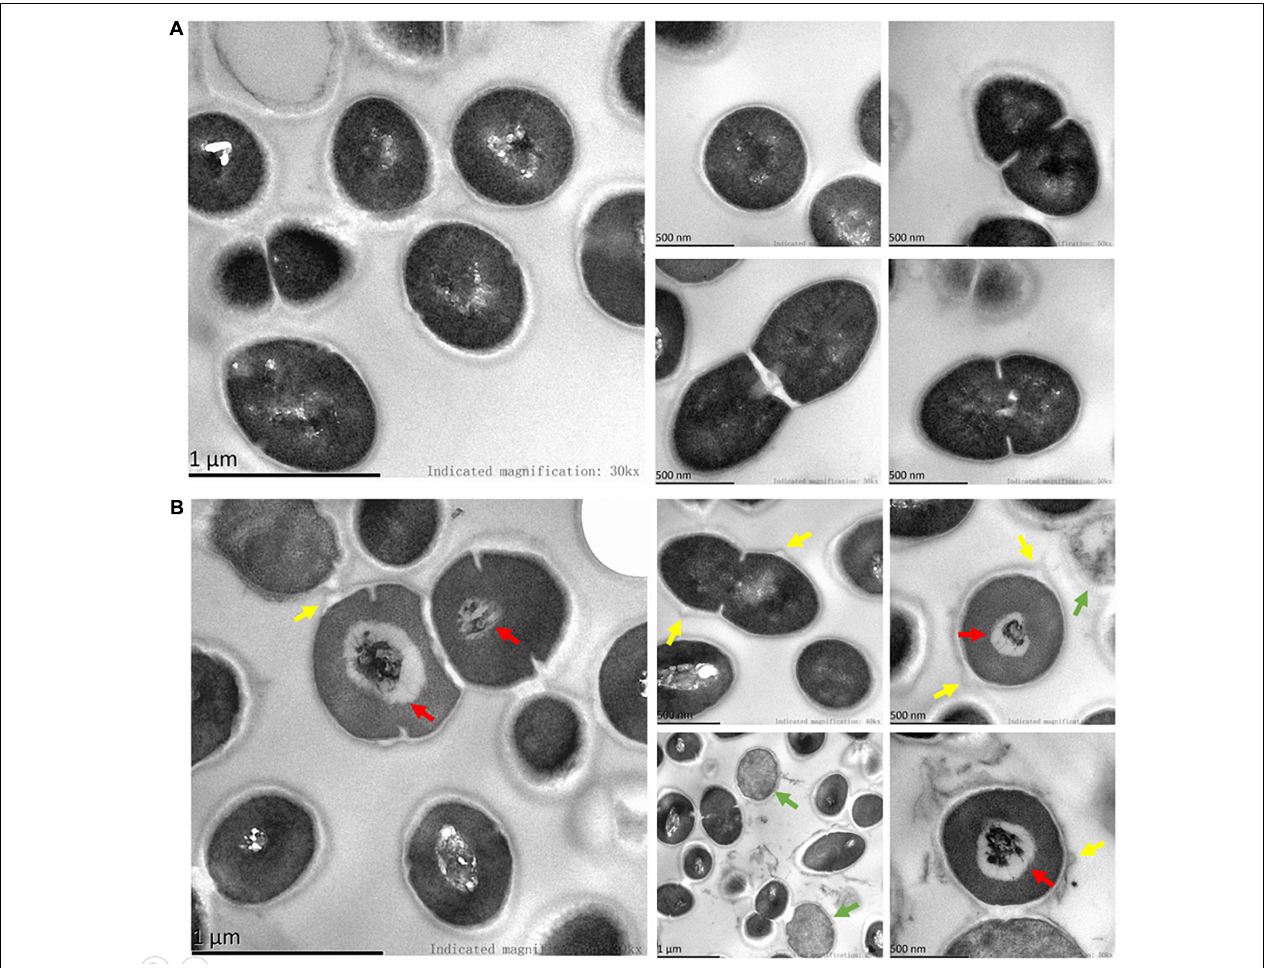
FIGURE 4 | TEM images of BT treatment of E. faecalis . (A) Control group, the cells were treated with 0.05% DMSO. (B) The bacterial cells were treated with 5 × MIC of BT for 1 h. Green arrows indicate dead cells; red arrows indicate dense deposits; yellow arrows indicate cell surface blebbing. TABLE 2 | FIC of antimicrobial combination against E. faecalis and E. faecium. Antibiotics E. faecalis Outcome E. faecium